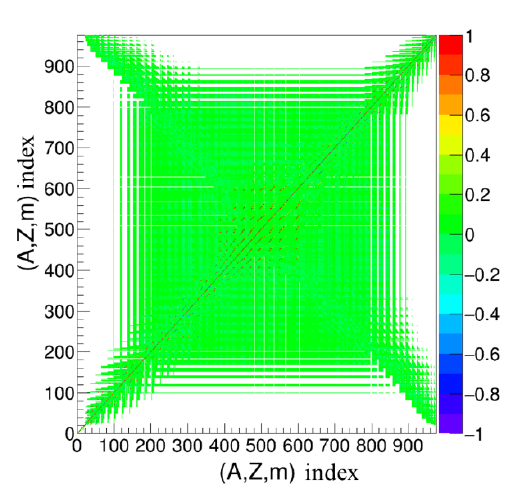
Fig. 13. Correlation matrix of cumulative yields of 235 U(n th ,f) [15].